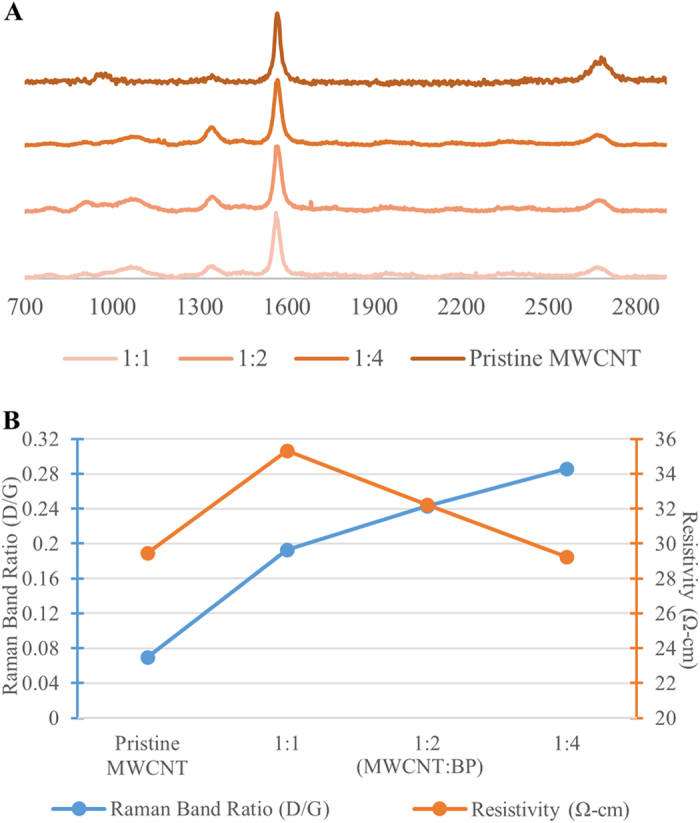
A) Representative Raman spectroscopy for MWCNT crosslinked films with three different mass ratios of MWCNT:BP (1:1, 1:2, 1:4). B) MWCNT crosslinked films sheet resistivity and tubular defects analyzed by a four point resistivity system and Raman spectroscopy (D/G bands) respectively.